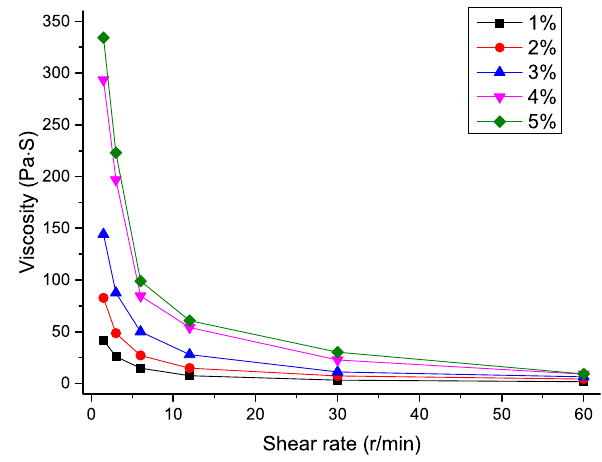
Fig. 3 Rheological behaviors of hydrocolloids with varying xanthan gum